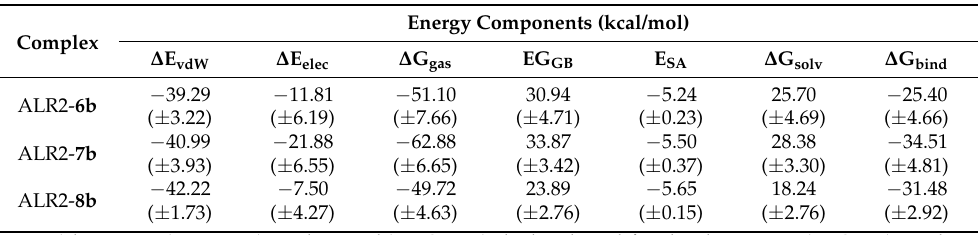
Table 4. Thermodynamics analysis. Summary of MM/GBSA-based binding free energy contributions to the ALR2- 6b , ALR2- 7b , and ALR2- 8b complexes. Energy Components (kcal/mol) Complex ∆ E